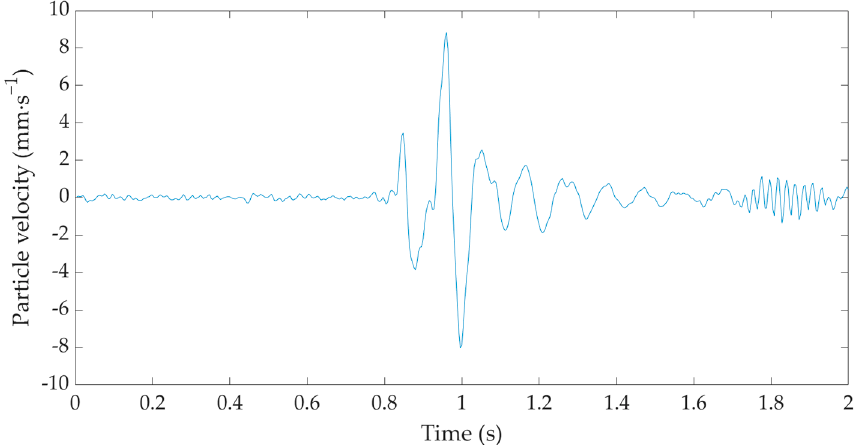
Figure 6. Time record of a hammer strike during the implementation of the gravel pile from the seismic station BRS32—M4.1a measurement diagram.